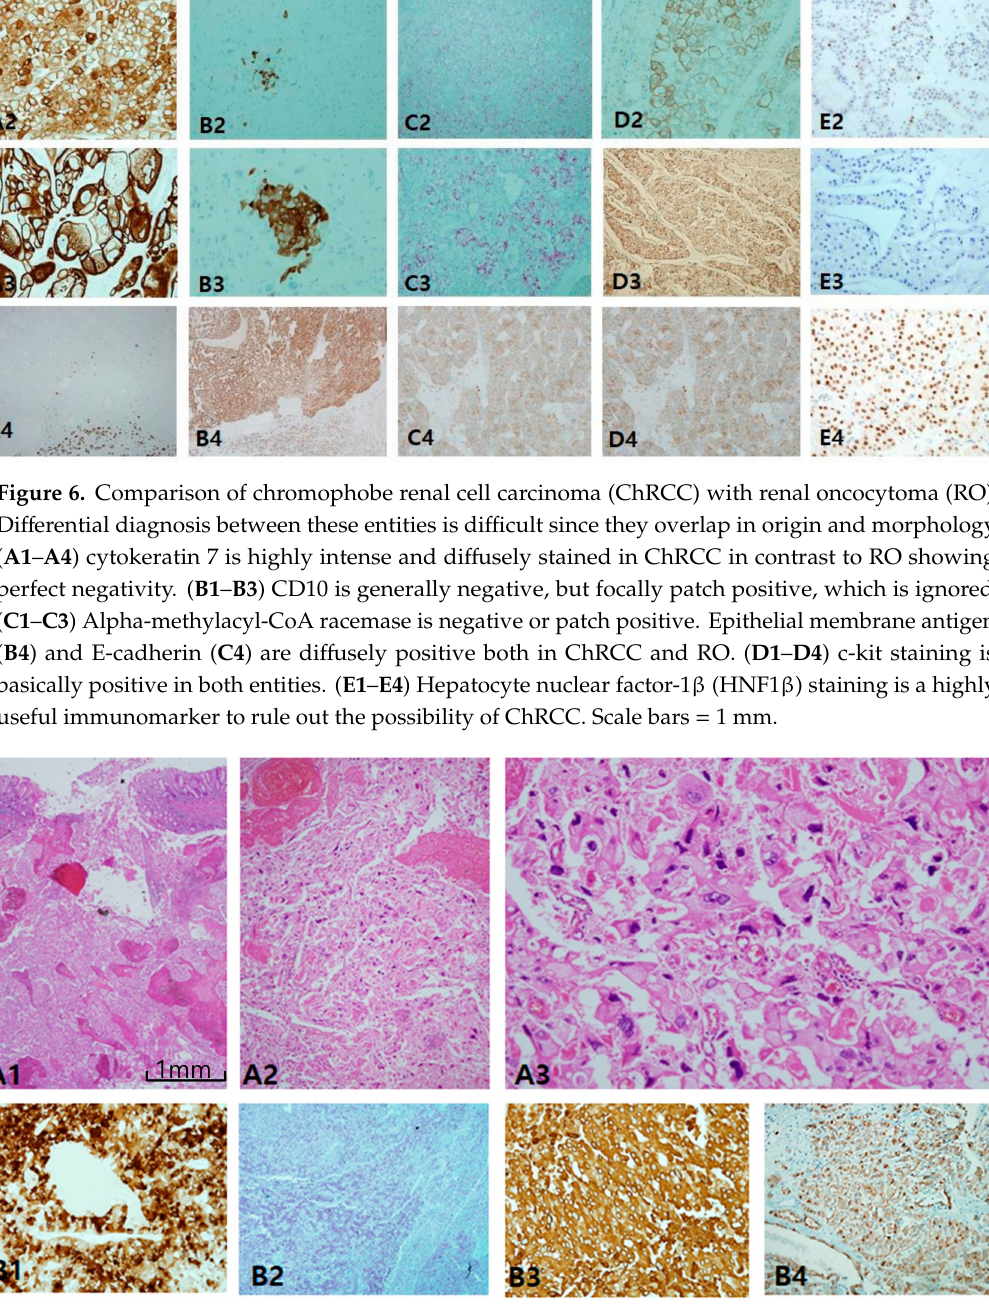
Figure 7. Alteration of immunoprofiles in aggressive chromophobe renal cell carcinoma (ChRCC). ( A1–A3 ) Aggressive behavior is uncommon in ChRCC, but few cases show metastasis and even rupture intestine ( A1 ). Tumor cells lost the nature of ChRCC, showing sarcomatoid di ff